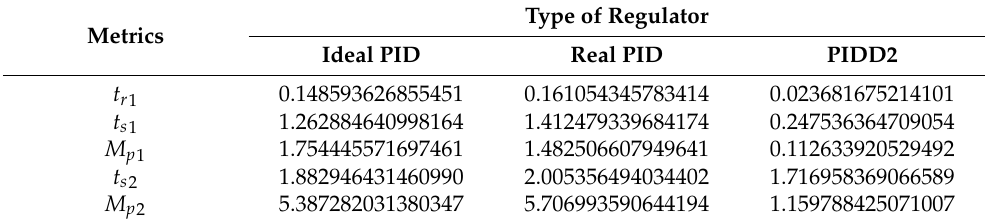
Table 3. The transient response